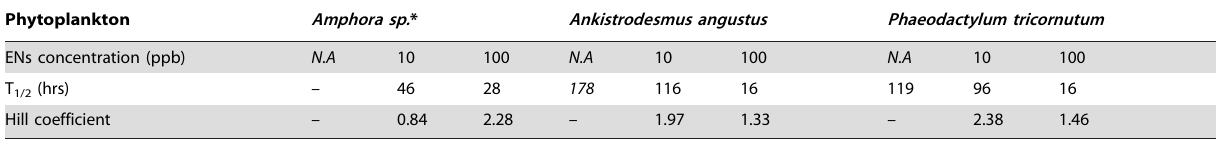
Table 2. EPS Assembly